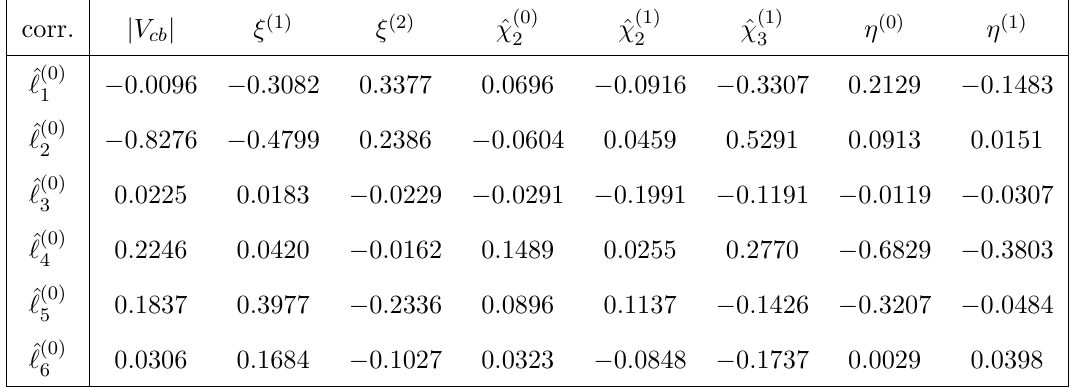
n (cid:24) ( n ) ; ^ (cid:31) ( n )